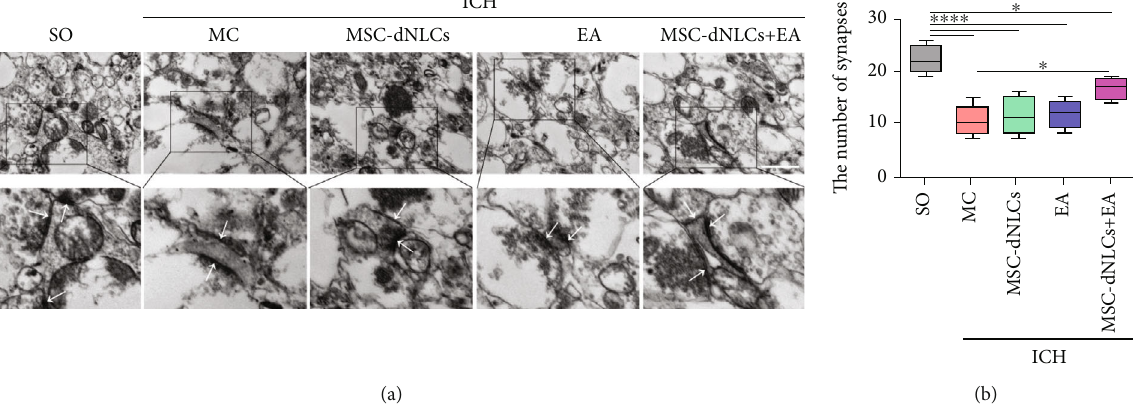
Figure 6: The combined treatment increased the number of synapses in rats with ICH. (a) Electron photomicrographs of synapses in the ipsilateral striatum of brain tissues from di ff erent groups. The white arrows show synapses. Scale bar = 1 μ m . (b) The number of synapses in the ipsilateral striatum (100 μ m 2 area) ( n = 5 rats per group; ∗ P < 0 : 05 and ∗∗∗∗ P < 0 : 0001